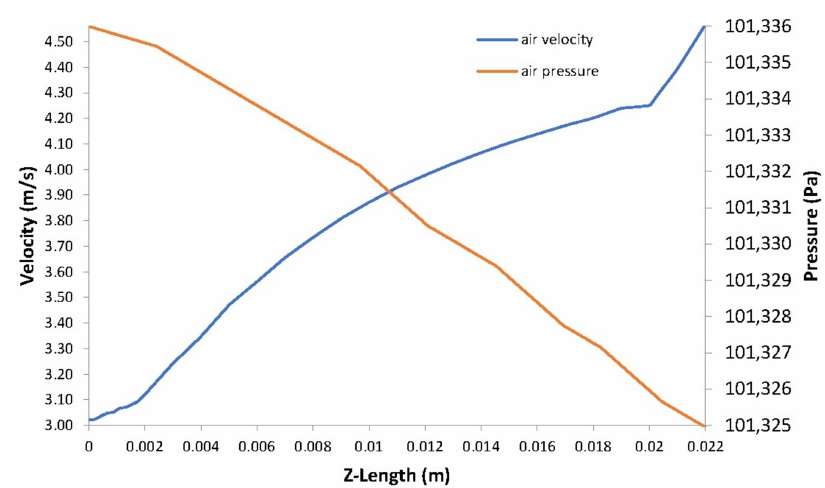
Figure 9. Air velocity vs. air pressure.